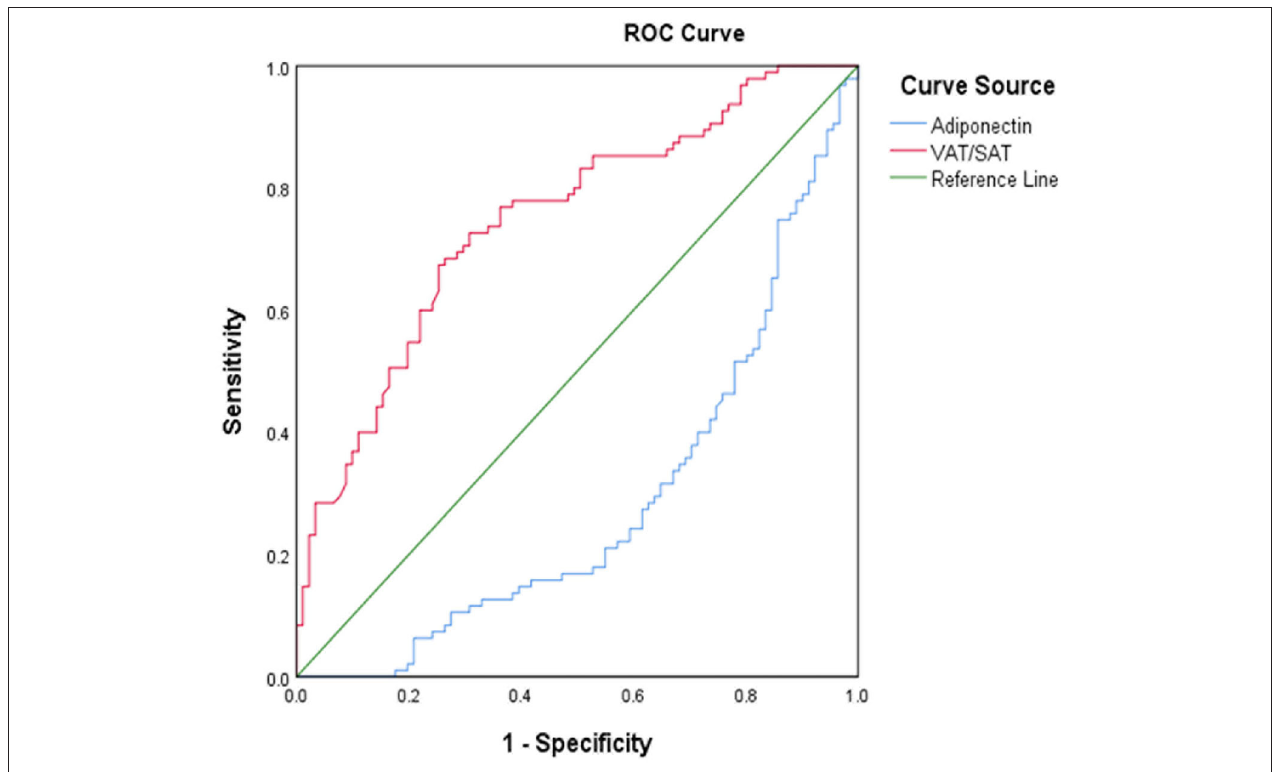
FIGURE 3 | ROC curve for VAT/SAT and adiponectin for distinguish between ICAS and non-ICAS. ROC, receiver operating characteristic curve; VAT, visceral adipose tissue; SAT, subcutaneous adipose tissue; ICAS, intracranial atherosclerotic stenosis.